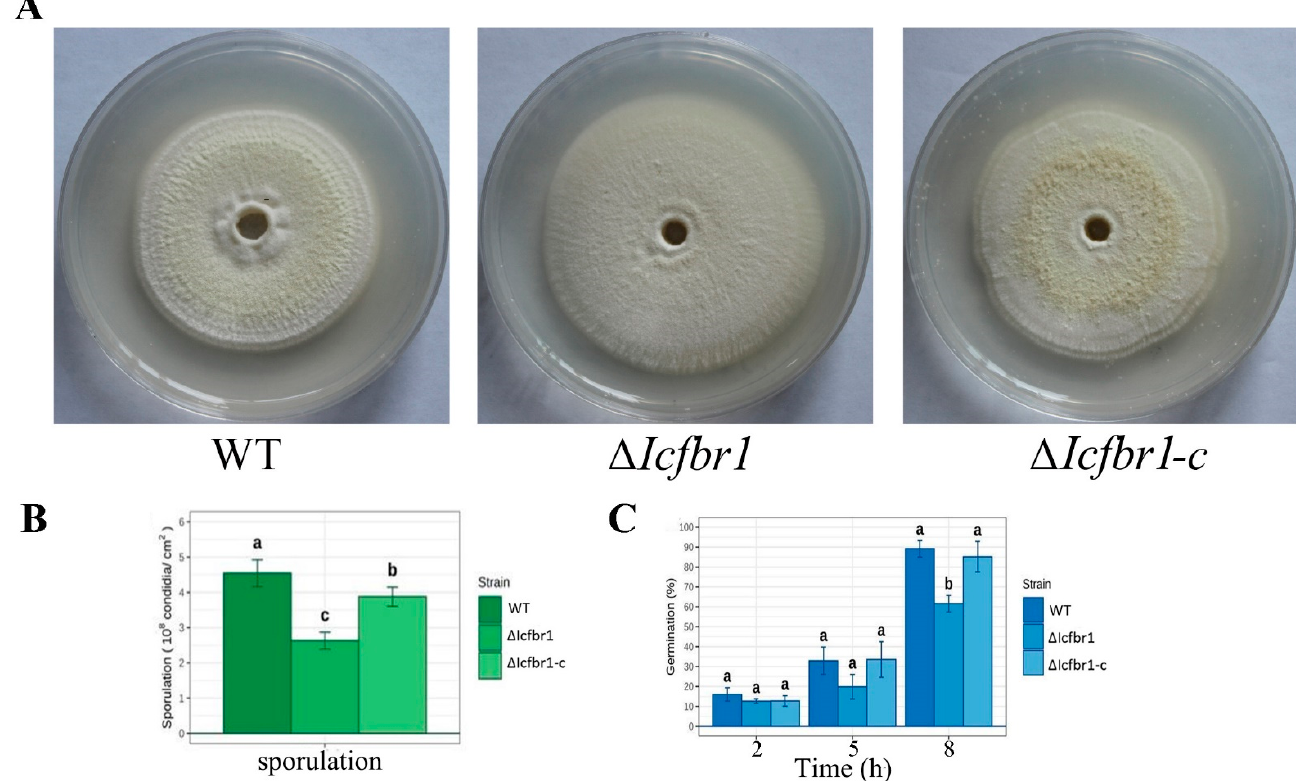
Figure 2. Phenotype characters of IcFBR1 null mutant. ( A ) Colony of WT, ∆ Icfbr1 , and ∆ Icfbr1-c were grown on PDA medium at 25 °C for 10 days and photographed. ( B ) Sporulation on PDA. ( C ) Spore germination on water agar. The same letters in the same stress item indicate a nonsignificant difference estimated ( p ≤ 0.05). All tests were repeated at least twice with three replicates of each treat- ment.